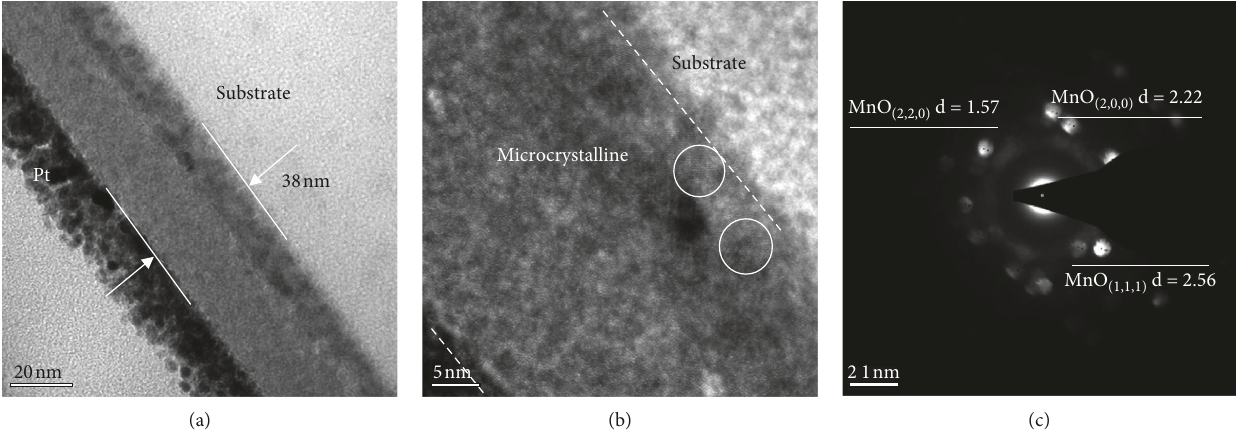
Figure 4: CuMn film TEM micrographs with 19.6 at.% Y addition annealed at 300 ° C: (a) cross-section bright field, (b) selected-area electron diffraction, (c) SAD analysis, and (d) HRTEM micrographs.